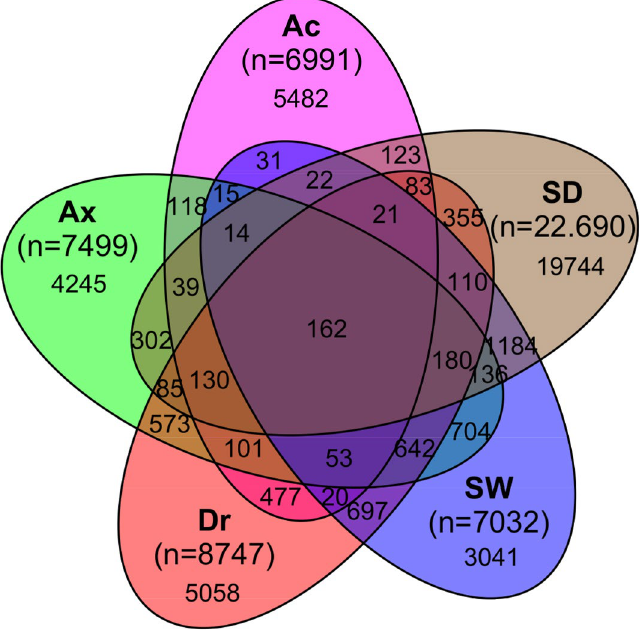
Figure 3. Venn diagram. All OTUs detected in Ap. caissara (Ac, magenta), Ax. corrugata (Ax, green), D. reticulatum (Dr, red), seawater (SW, blue), and sediment (SD,